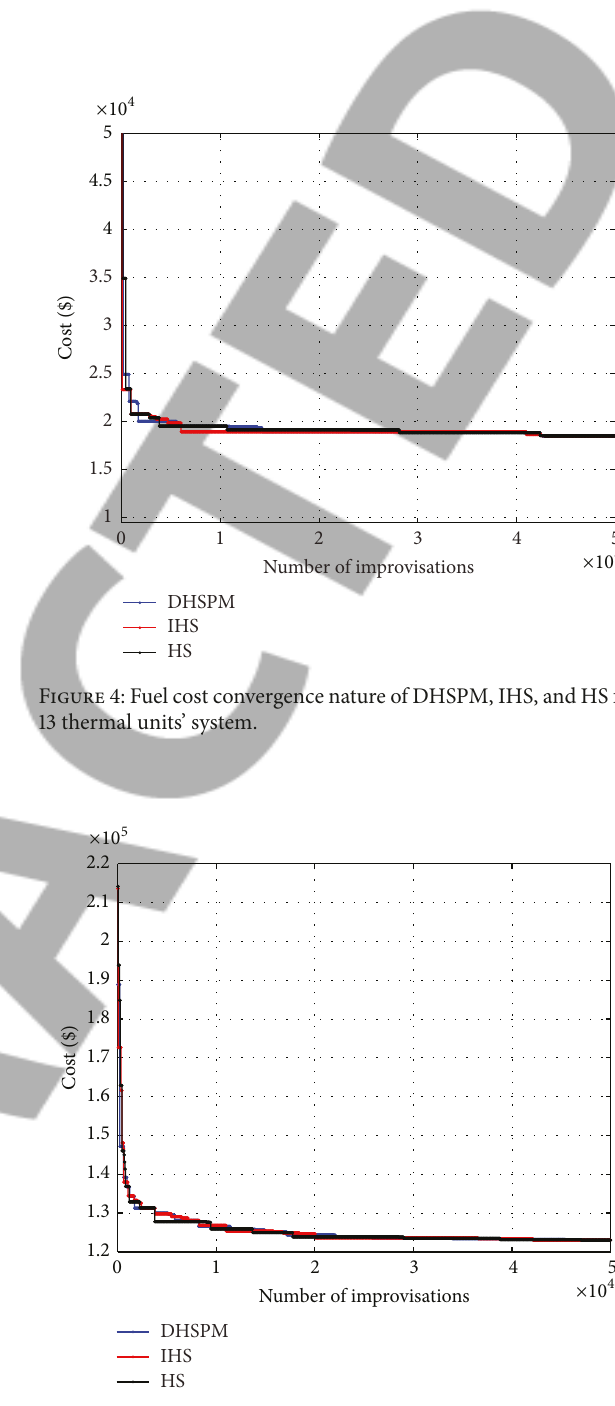
Figure 5: Fuel cost convergence nature of DHSPM, IHS, and HS for 40 thermal units’